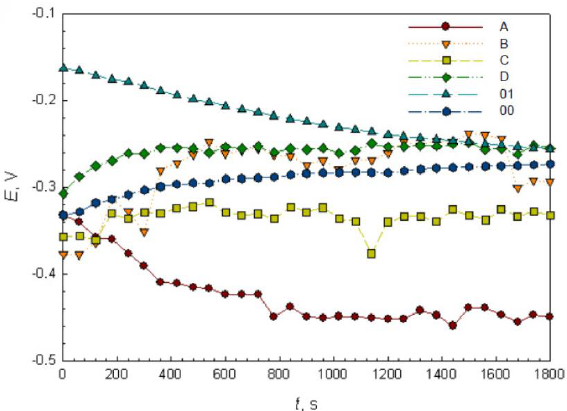
Figure 1. The open circuit potential of powder coating as a function of time, in 4% w/w NaOH solution.